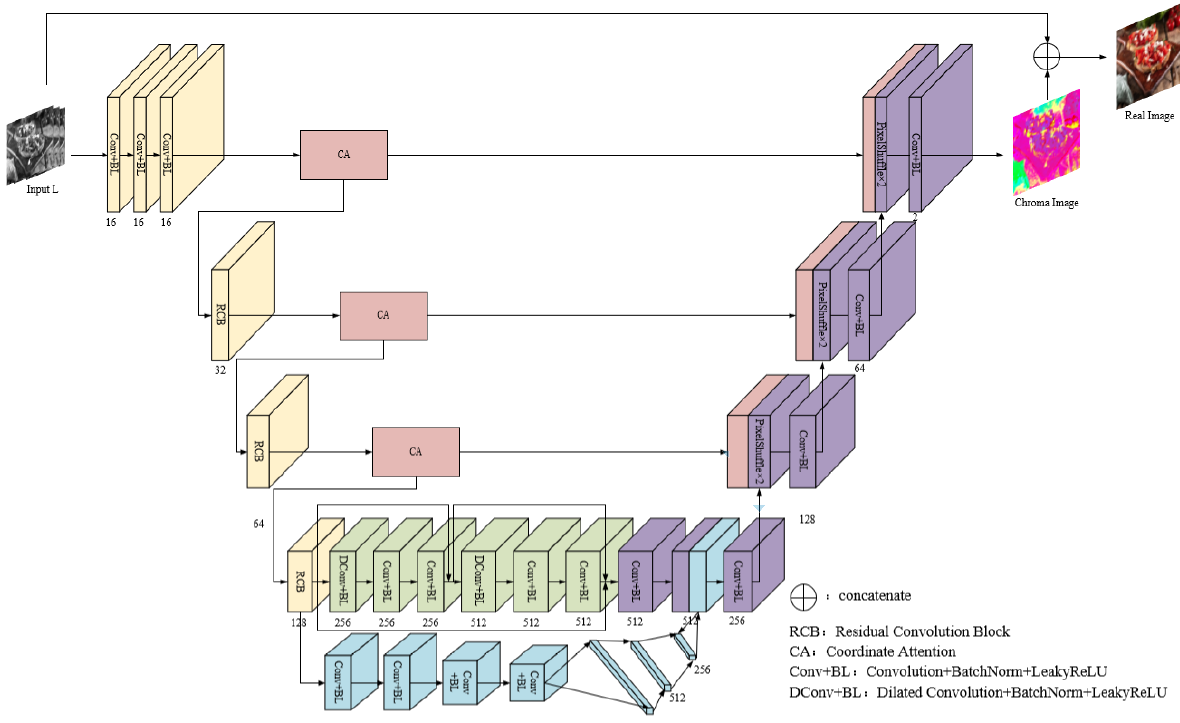
Figure 2. The structure of generator.